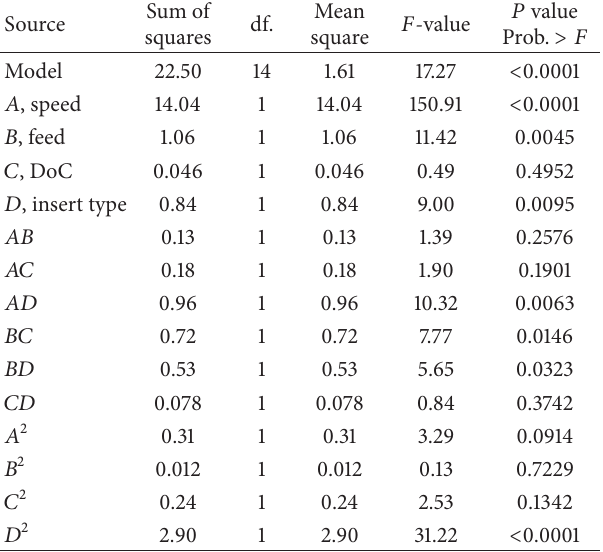
Table 4: ANOVA for Response-1 surface roughness ( 𝑅 𝑎